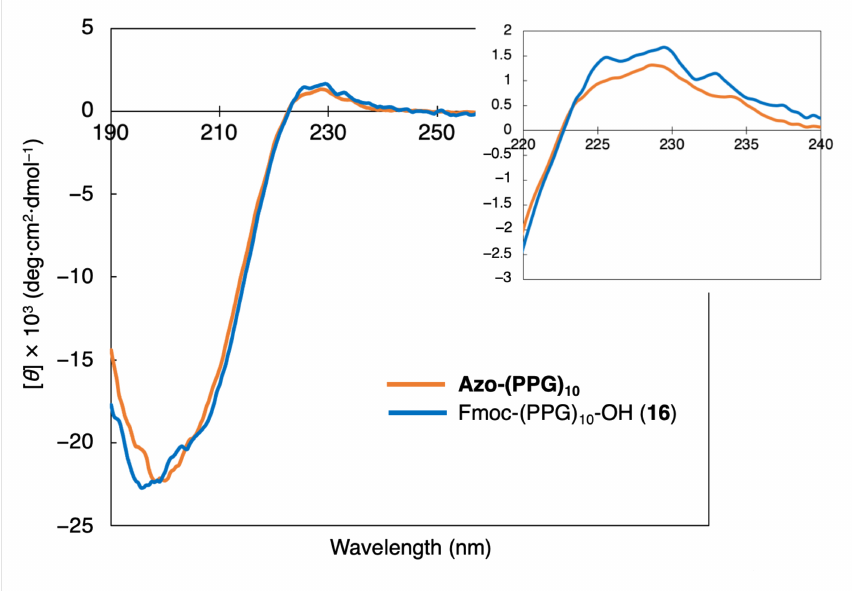
Figure 2. CD spectra of Azo-(PPG) 10 and the positive control Fmoc-(PPG) 10 -OH ( 16 ). The inset shows the spectra over the range of the characteristic maximal peak for the collagen triple helix structure.